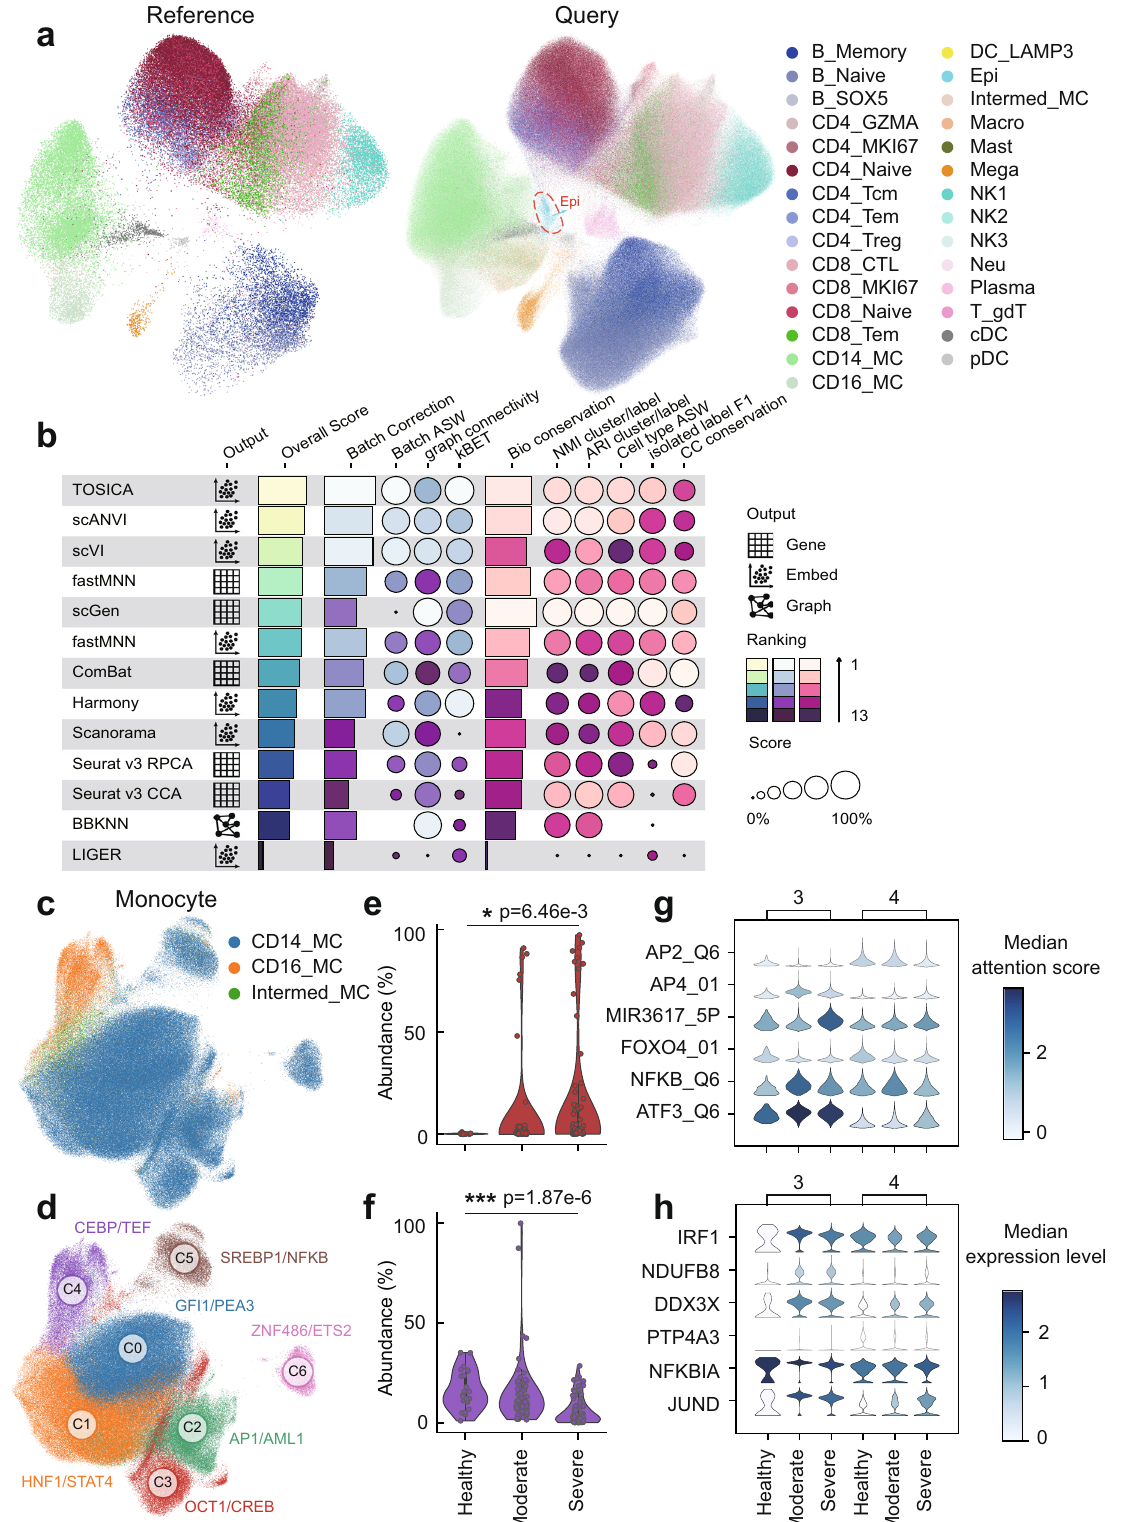
Fig.5|TOSICArevealschangeintranscriptionfactoractivityduringmoderate and severe COVID-19. a TOSICA predicts cell types reliably across different cell typesevenwhenusing healthyindividualsasreference(left)and COVID19patients asquery (right). Colorsdenote29 origin labels. Red circledcelltypesare unique in query. b Comparison of integration accuracy on query data places TOSICA fi rst among 13 methods. Each score is minimum – maximum scaled between 0 and 1. Overallscoresarecomputedusinga40:60-weightedmeanofbatchcorrectionand bio-conservationscores. c , d TOSICAattentionscorebasedUMAPpredicts3known